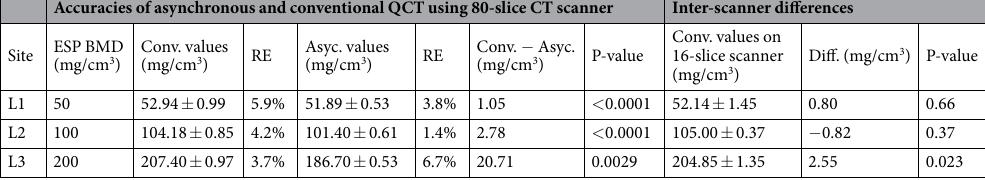
Table 2. The accuracies of asynchronous and conventional quantitative computed tomography (QCT) and comparisons of inter-scanner differences. Asyc., asynchronous QCT method; BMD, bone mineral density; Conv., conventional QCT; ESP, European spine phantom; RE, Relative error; Diff. difference defined as 80-slice scanner – 16-slice scanner. Data represent the mean ± standard